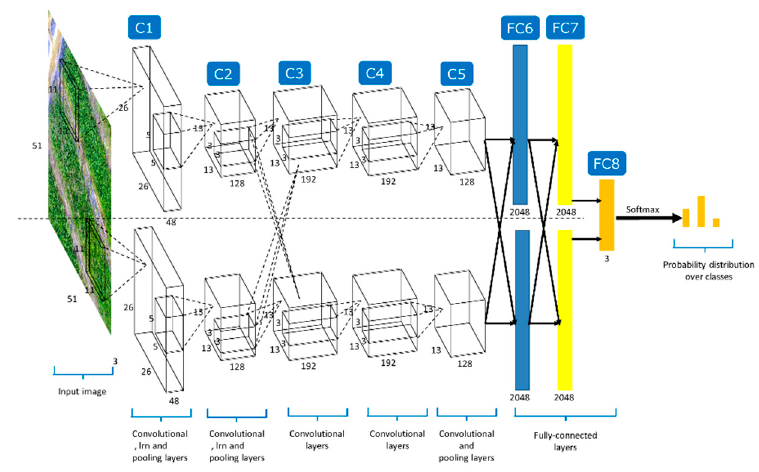
Figure 6. General architecture of AlexNet.